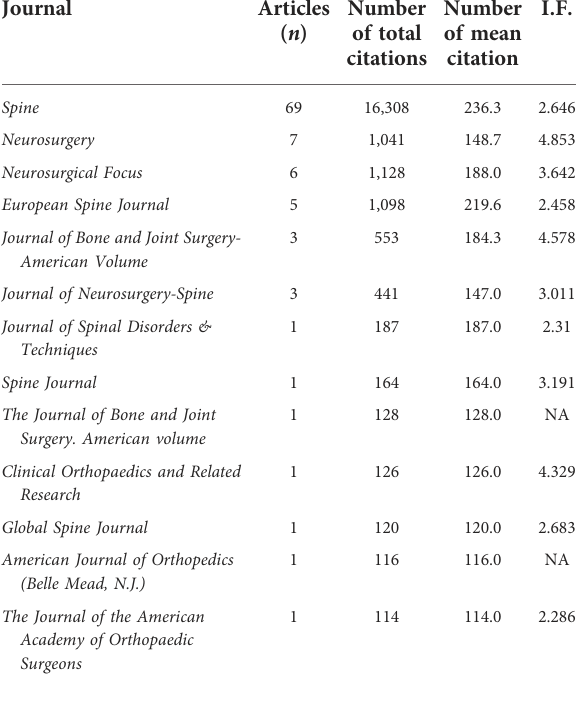
TABLE 4 The journals in which the top-cited 100 articles were published.